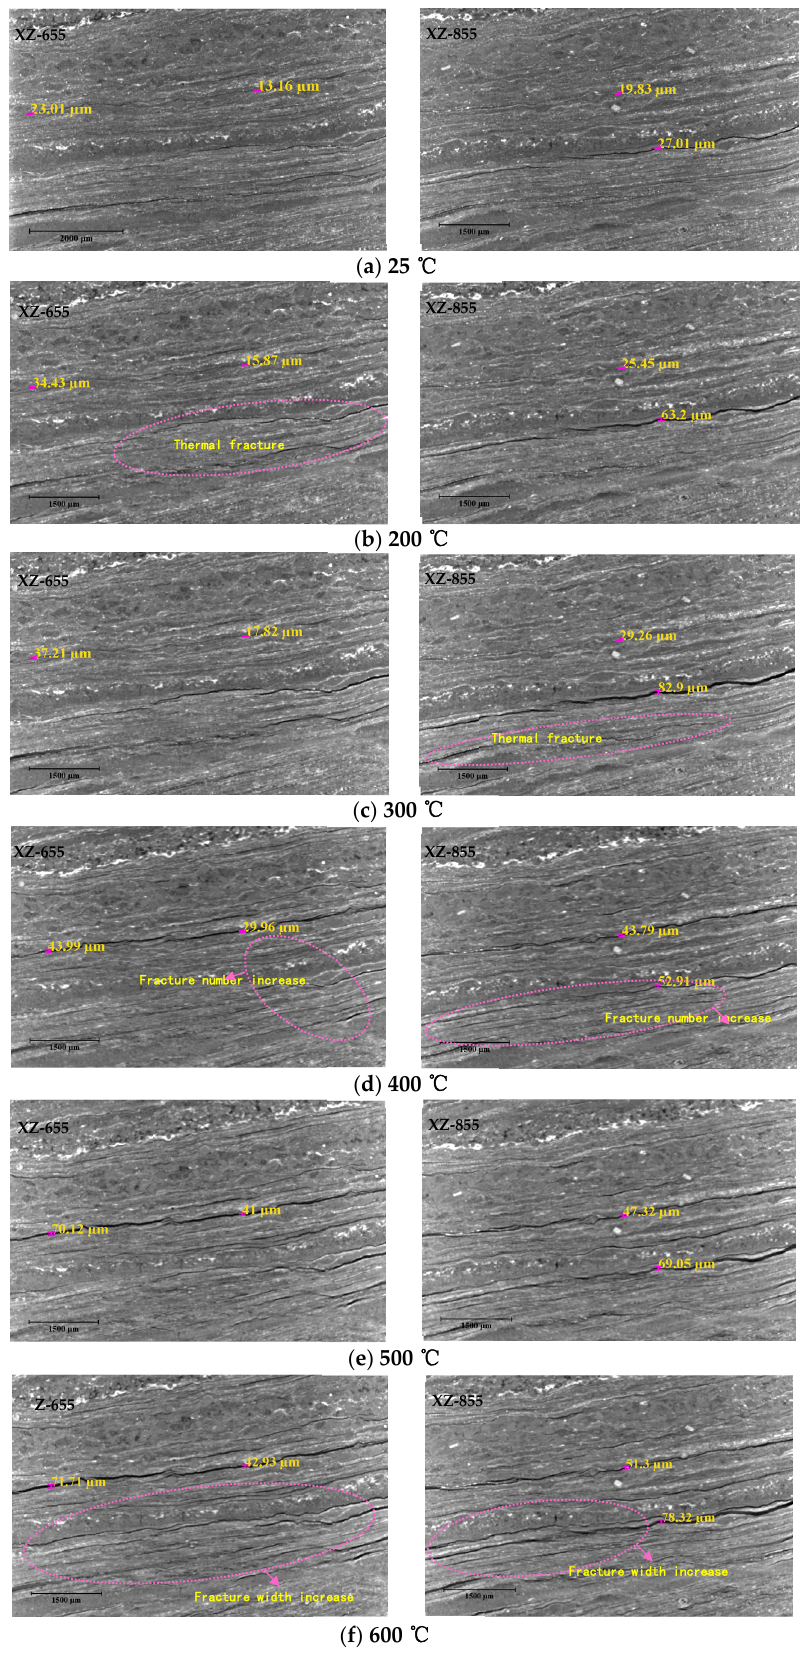
Figure 7. Structural evolution of the oil shale at different positions in the XZ direction at different temperatures.